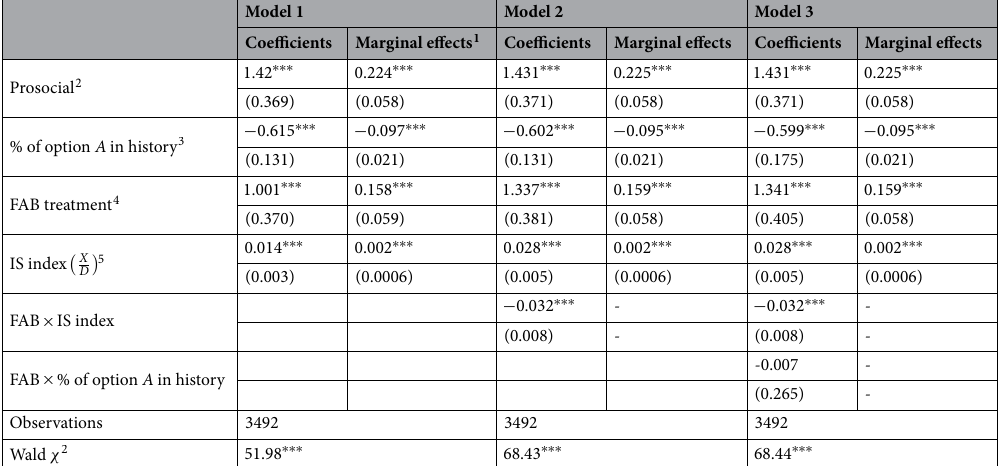
Table 3. Panel logit models with a dummy variable of the binary choice between options A and B as the dependent variable, with the choice of option A is the base group. Standard errors in